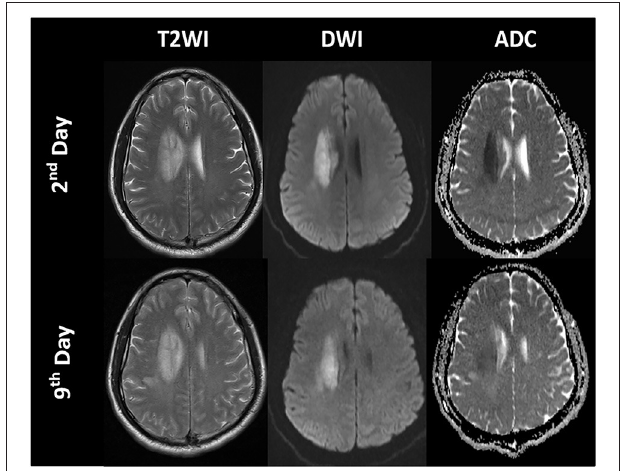
FIGURE 4 | Time course of the signal intensities in T2-weighted imaging (T2WI), diffusion-weighted imaging (DWI), and apparent diffusion coefficient (ADC) maps of a patient with a right paraventricular infarct.